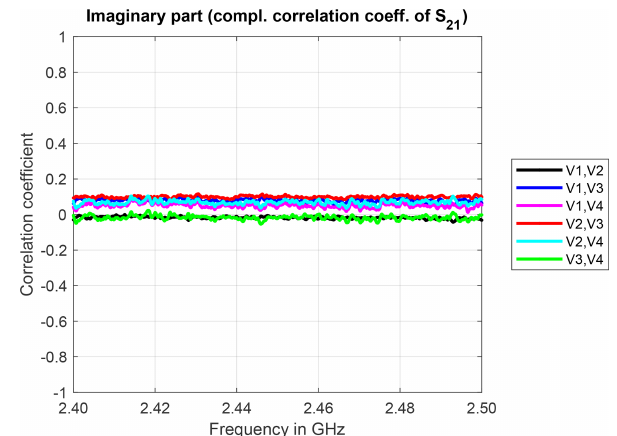
Figure 4. Imaginary part of the complex correlation coefficients for identically constructed antennas and measurement trial 4.